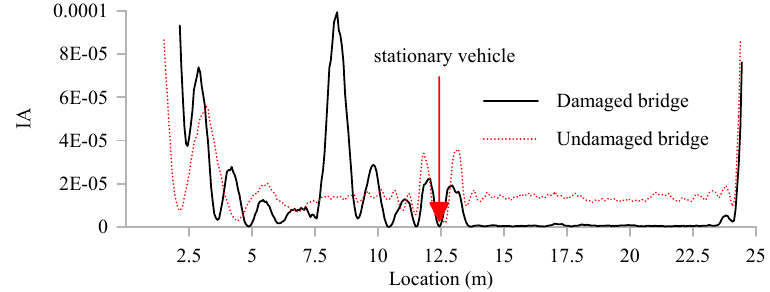
Figure 8. IA of the IMF for the healthy and damaged bridge.